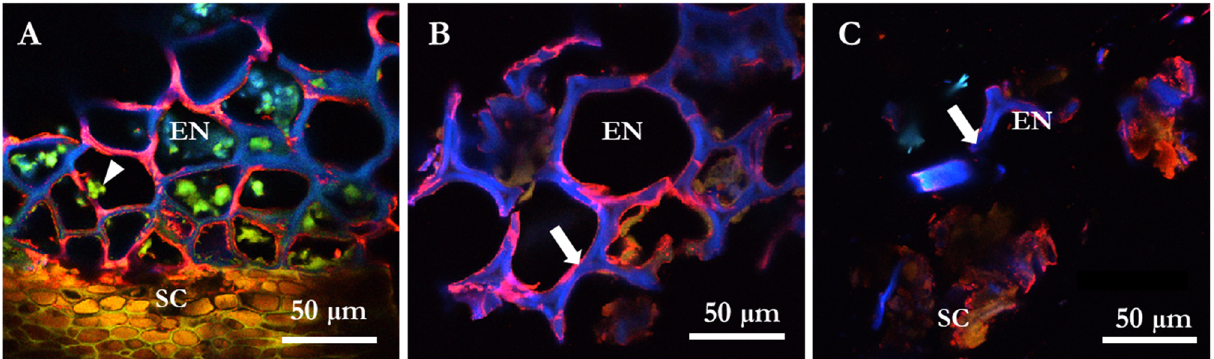
Figure 4. Confocal overlay images of cross sections from palm kernel cake (PKC) labelled with the immunofluorescent probe LM 21 detecting β -mannans (red signal) and calcofluor white dye staining cellulose containing β -glucan linkages (blue signal). Panel ( A ) shows the endosperm cells (EN) with content of protein bodies (arrow head) and the seed coat (SC) in a control section. In panel ( B ) the localization of β -mannan and β -glucan is seen within the intact thick-walled EN (arrow) in a control section. Panel ( C ) shows the disruption of cell wall structures (arrow) after treatment with a commercial dosage of a β